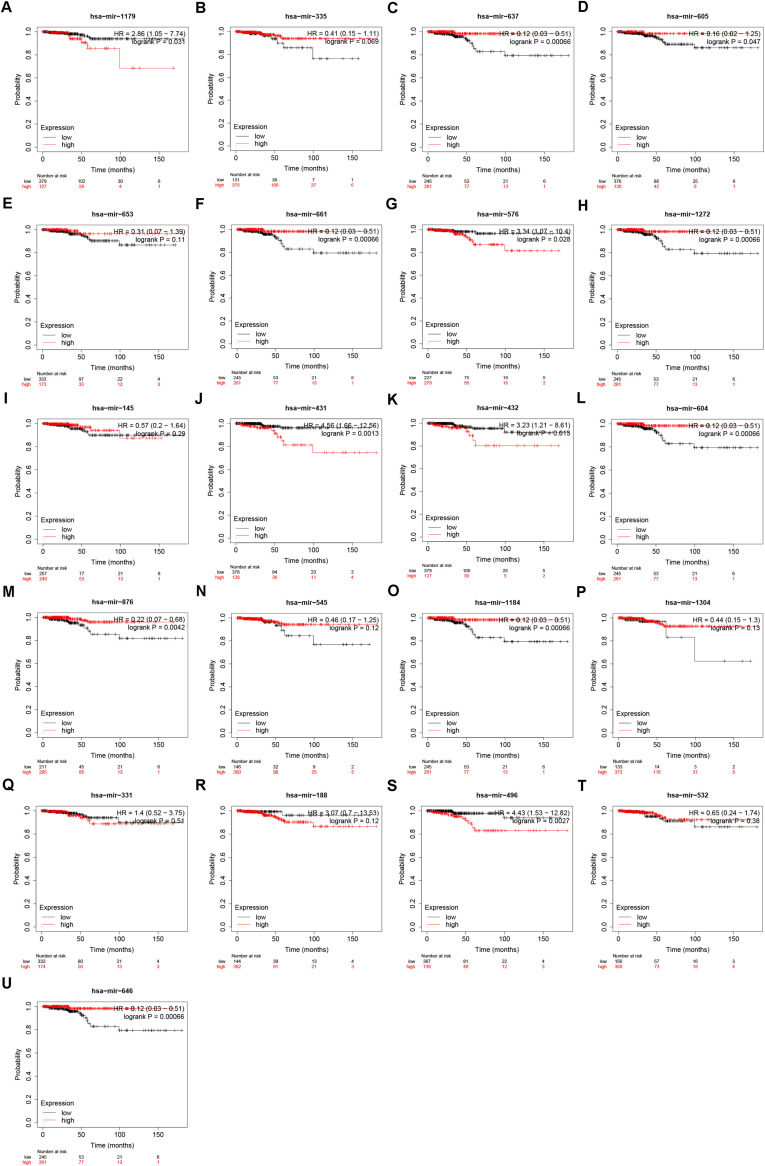
The prognostic values of 21 predicted miRNAs that potentially bind to 9 candidate circRNAs in thyroid carcinoma. (A) The prognostic value of miR-1179 in thyroid carcinoma. (B) The prognostic value of miR-335-5p in thyroid carcinoma. (C) The prognostic value of miR-637 in thyroid carcinoma. (D) The prognostic value of miR-605-5p in thyroid carcinoma. (E) The prognostic value of miR-653-5p in thyroid carcinoma. (F) The prognostic value of miR-661 in thyroid carcinoma. (G) The prognostic value of miR-576-3p in thyroid carcinoma. (H) The prognostic value of miR-1272 in thyroid carcinoma. (I) The prognostic value of miR-145-5p in thyroid carcinoma. (J) The prognostic value of miR-431-5p in thyroid carcinoma. (K) The prognostic value of miR-432-5p in thyroid carcinoma. (L) The prognostic value of miR-604 in thyroid carcinoma. (M) The prognostic value of miR-876-3p in thyroid carcinoma. (N) The prognostic value of miR-545-3p in thyroid carcinoma. (O) The prognostic value of miR-1184 in thyroid carcinoma. (P) The prognostic value of miR-1304-3p in thyroid carcinoma. (Q) The prognostic value of miR-331-3p in thyroid carcinoma. (R) The prognostic value of miR-188-3p in thyroid carcinoma. (S) The prognostic value of miR-496 in thyroid carcinoma. (T) The prognostic value of miR-532-3p in thyroid carcinoma. (U) The prognostic value of miR-646 in thyroid carcinoma. “logrank P < 0.05” represents significant difference.